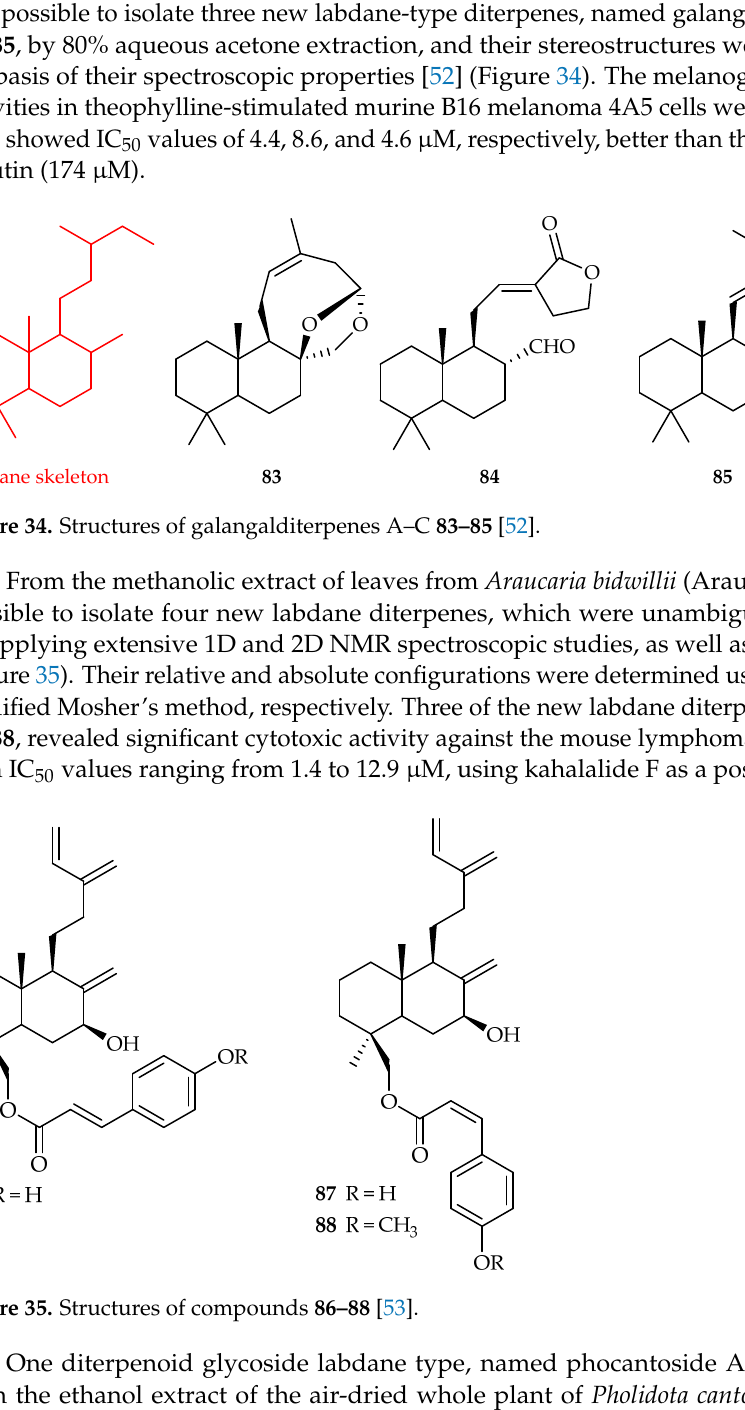
Figure 33. Structure of crassin H 82 [51].